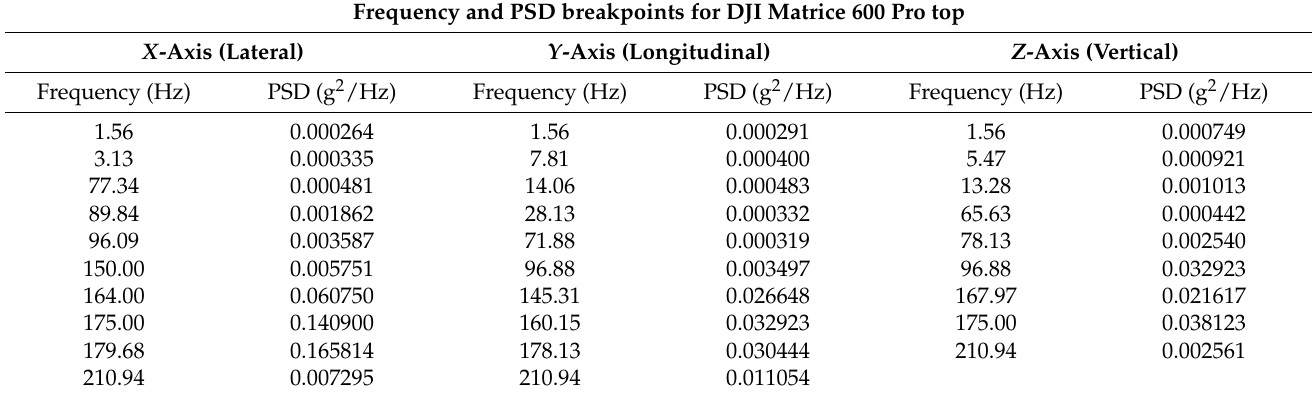
Table 3. Frequencies and PSD breakpoints for DJI Matrice 600 Pro.